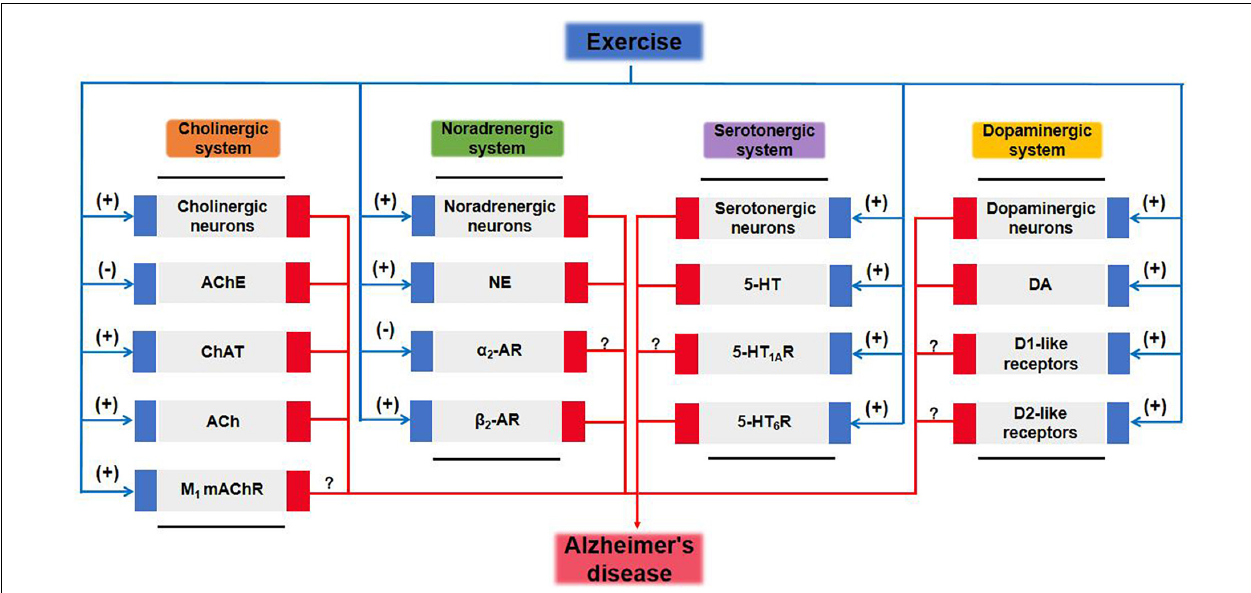
FIGURE 2 | Cholinergic and monoaminergic systems mediate potential pathways for exercise amelioration in Alzheimer’s disease. 5-HT, 5-hydroxytryptamine; 5-HTR, 5-hydroxytryptamine receptor; ACh, acetylcholine; AChE, acetylcholinesterase; AR, adrenergic receptor; ChAT, choline acetyltransferase; DA, dopamine; mAChR, muscarinic acetylcholine receptor; MAOA, monoamine oxidase A; NE, norepinephrine.